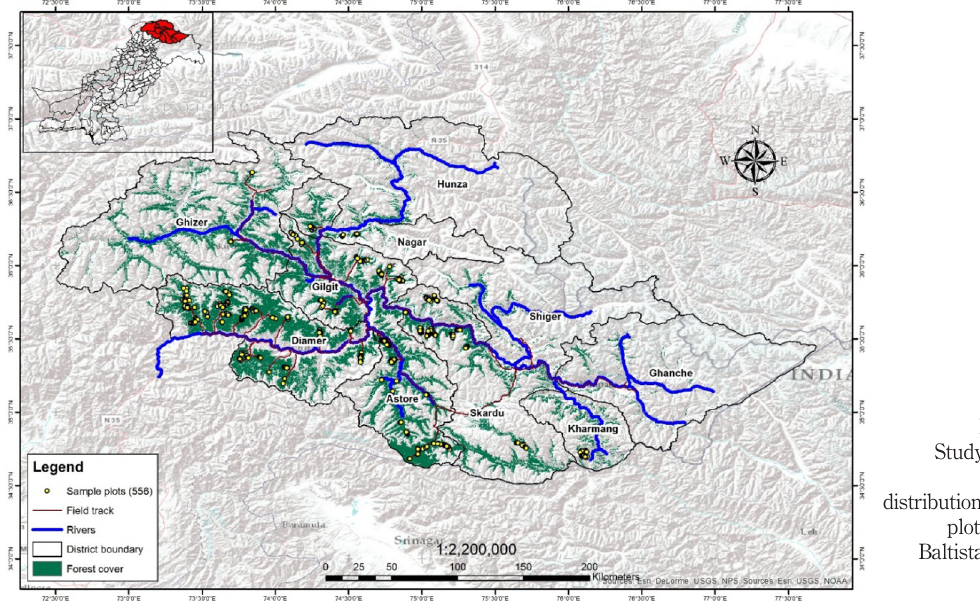
Figure 1. Study area map shows the distribution of sample plots in Gilgit- Baltistan forested